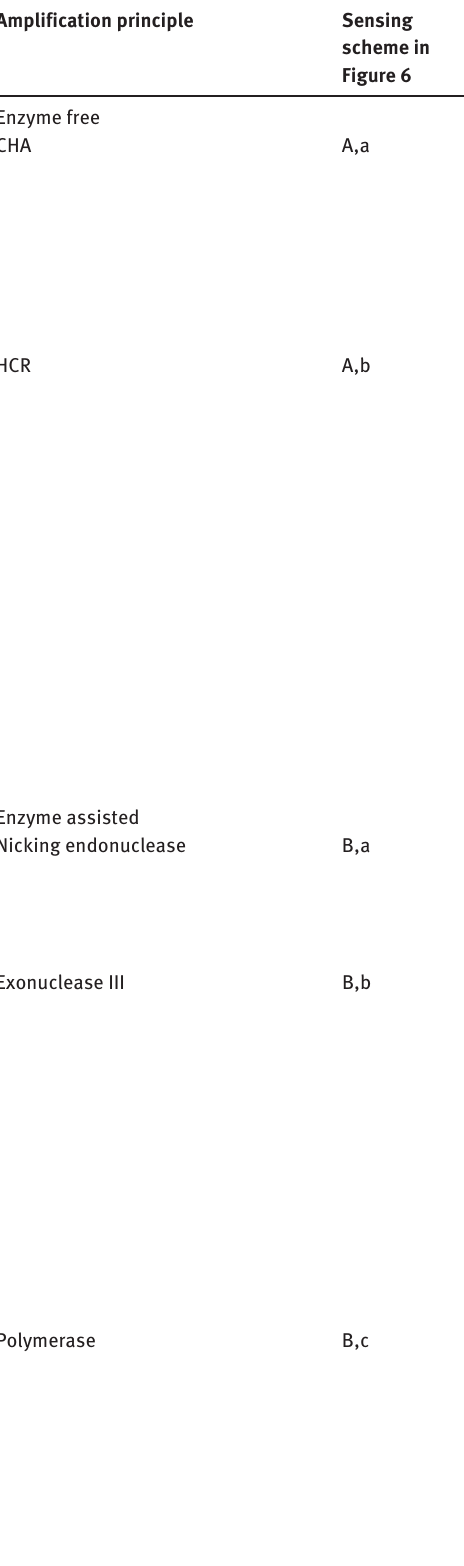
Table 5: Sensing methods using signal amplification